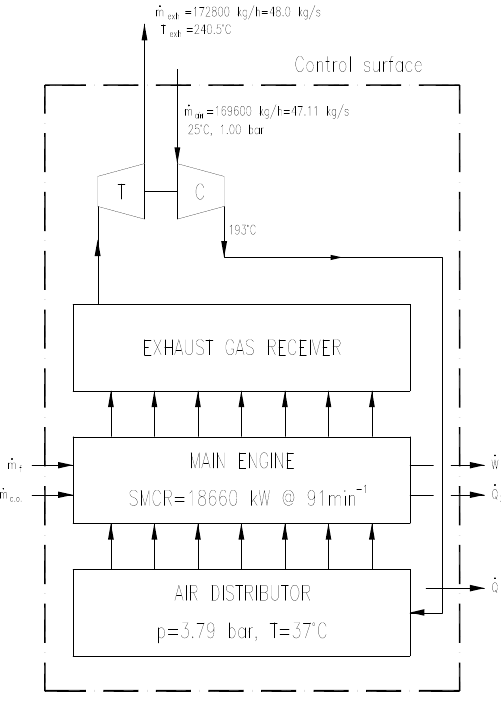
Figure 3. Schematic diagram of the conventional main engine 6S70MC-C7 for ISO conditions and 100% specified maximum continuous rating ( SMCR).